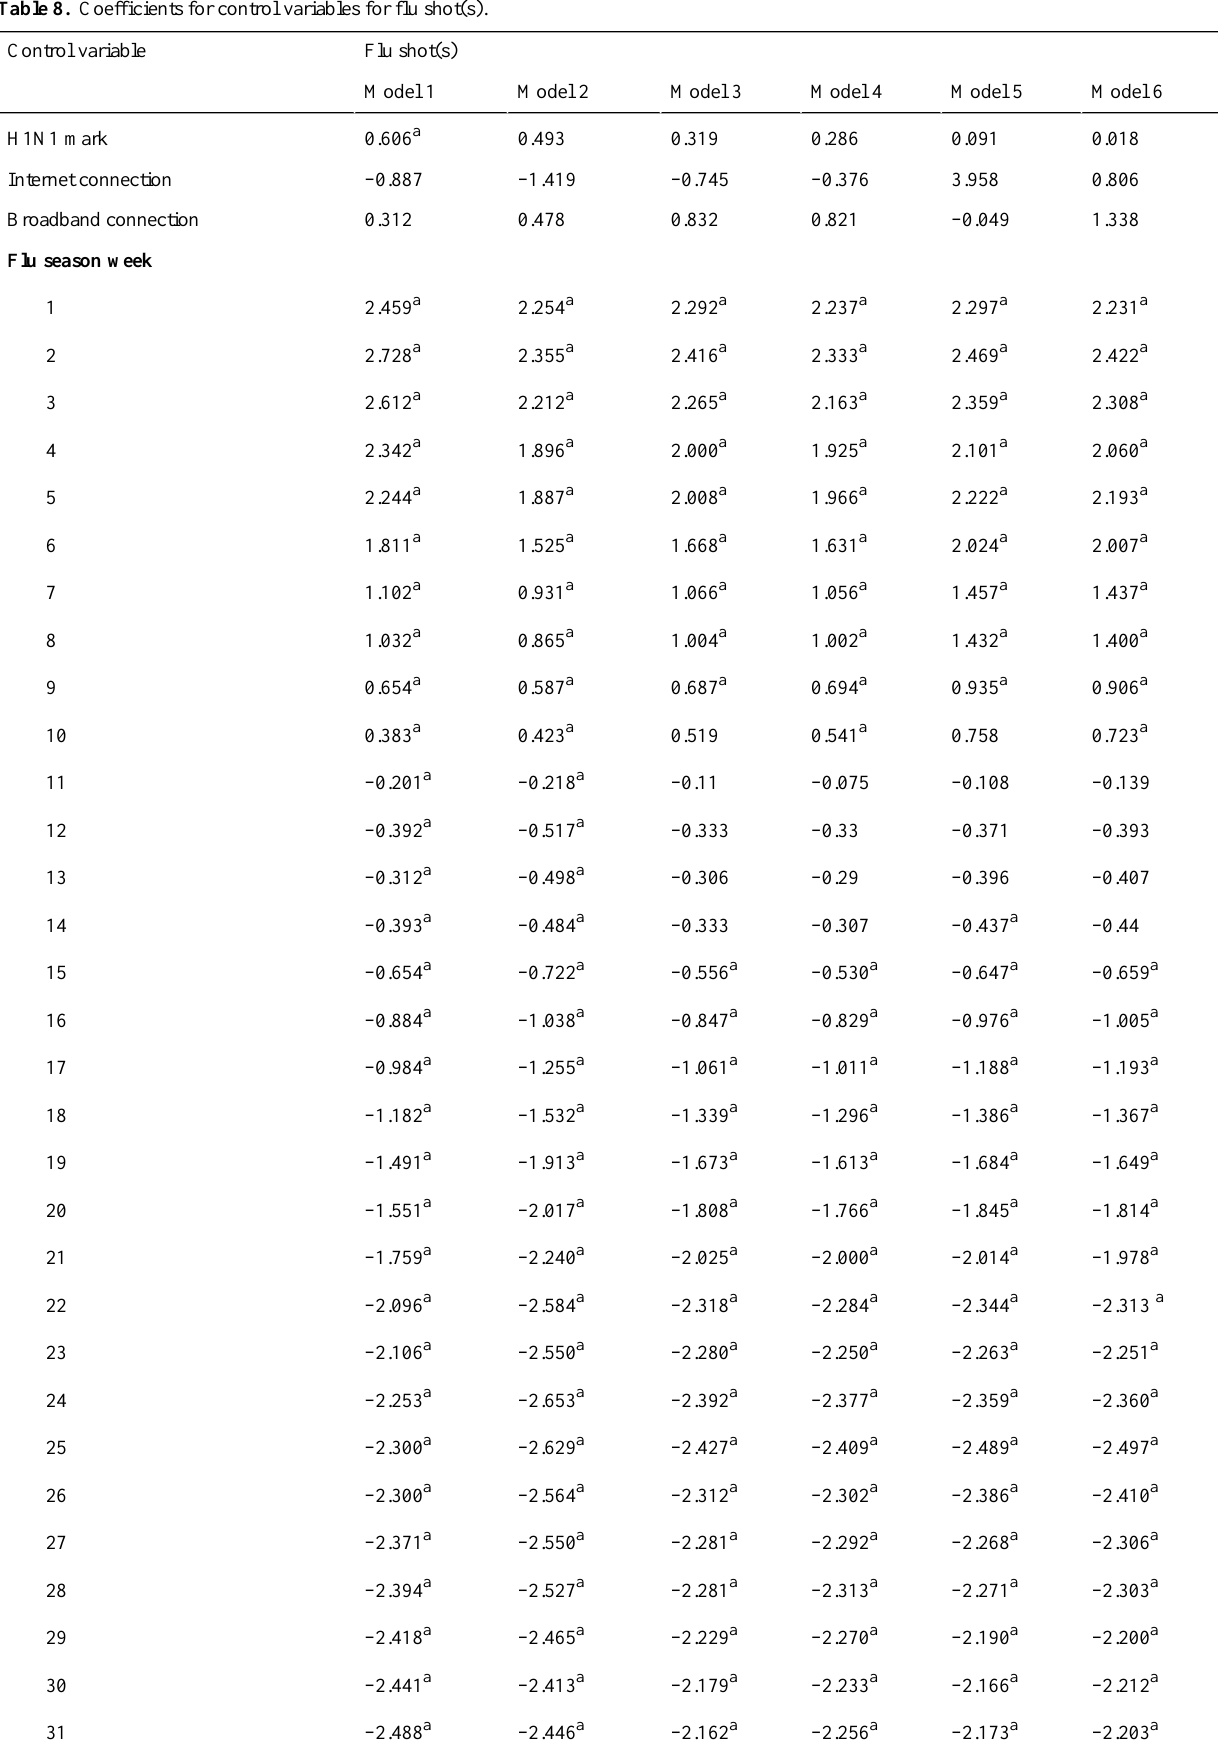
Table 8. Coefficients for control variables for flu